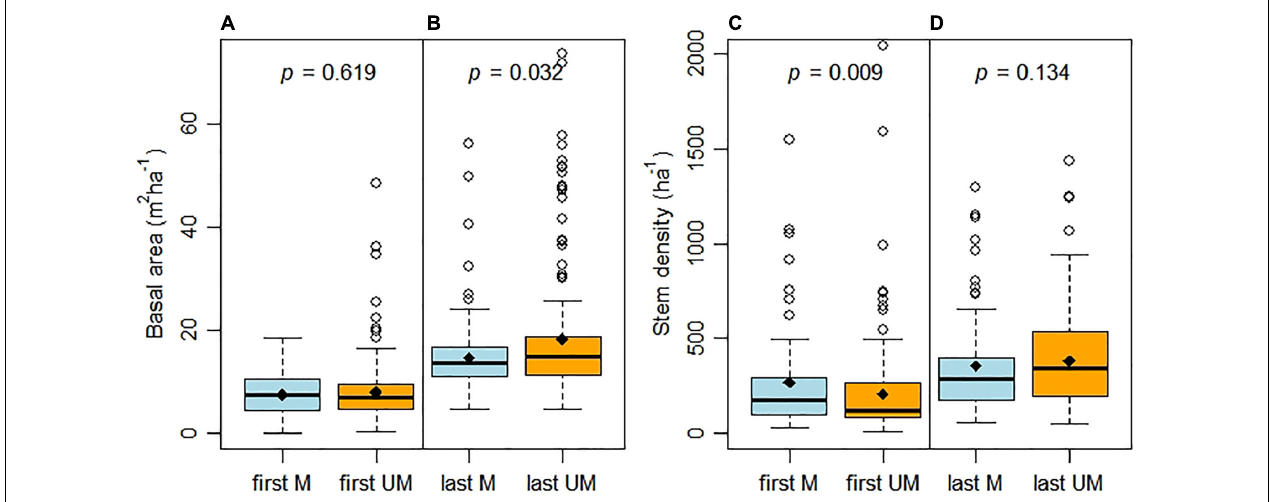
FIGURE 4 | Basal area (A,B) and stem density (C,D) at first and last measurements for managed (M) and unmanaged (UM) plots. Observation numbers were the same, n = 130 (M) and n = 175 (UM) in each case. At least one tree was harvested between first and last measurement in managed plots. We only used plots where measurement periods were 10 years or longer (mean 40 years; min–max 10–79 years). p -values of covariance analysis are based on Kruskal-Wallis tests. Boxes represent the median and the 25th and 75th quantile. Diamonds indicate arithmetic means, while whiskers extend to 1.5 of the interquartile range, values outside this range are indicated by